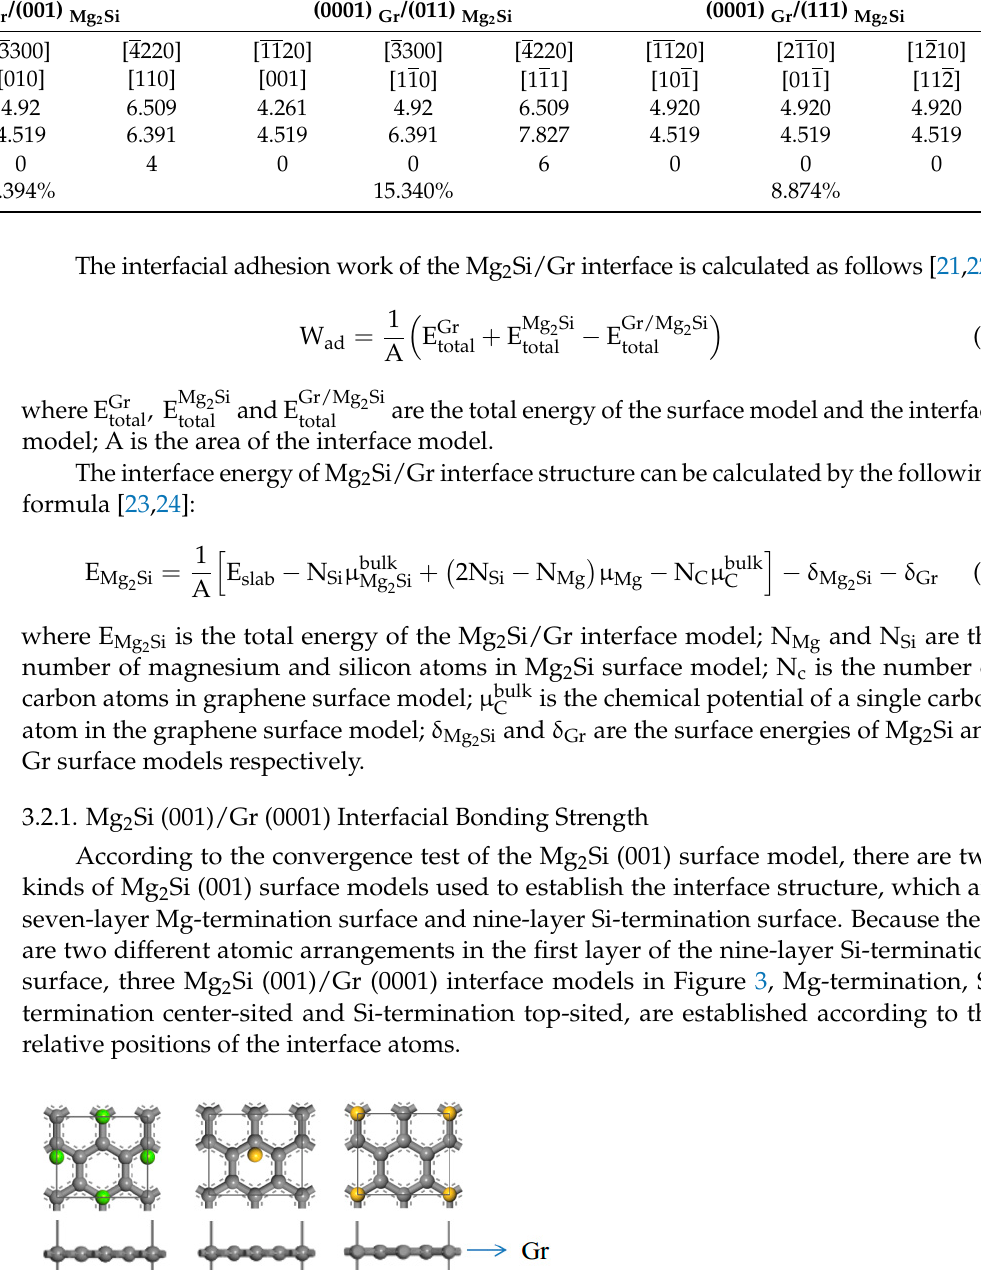
Table 1. The matching parameters of potential crystallographic orientation relationship between Gr and Mg 2 Si. Parameter